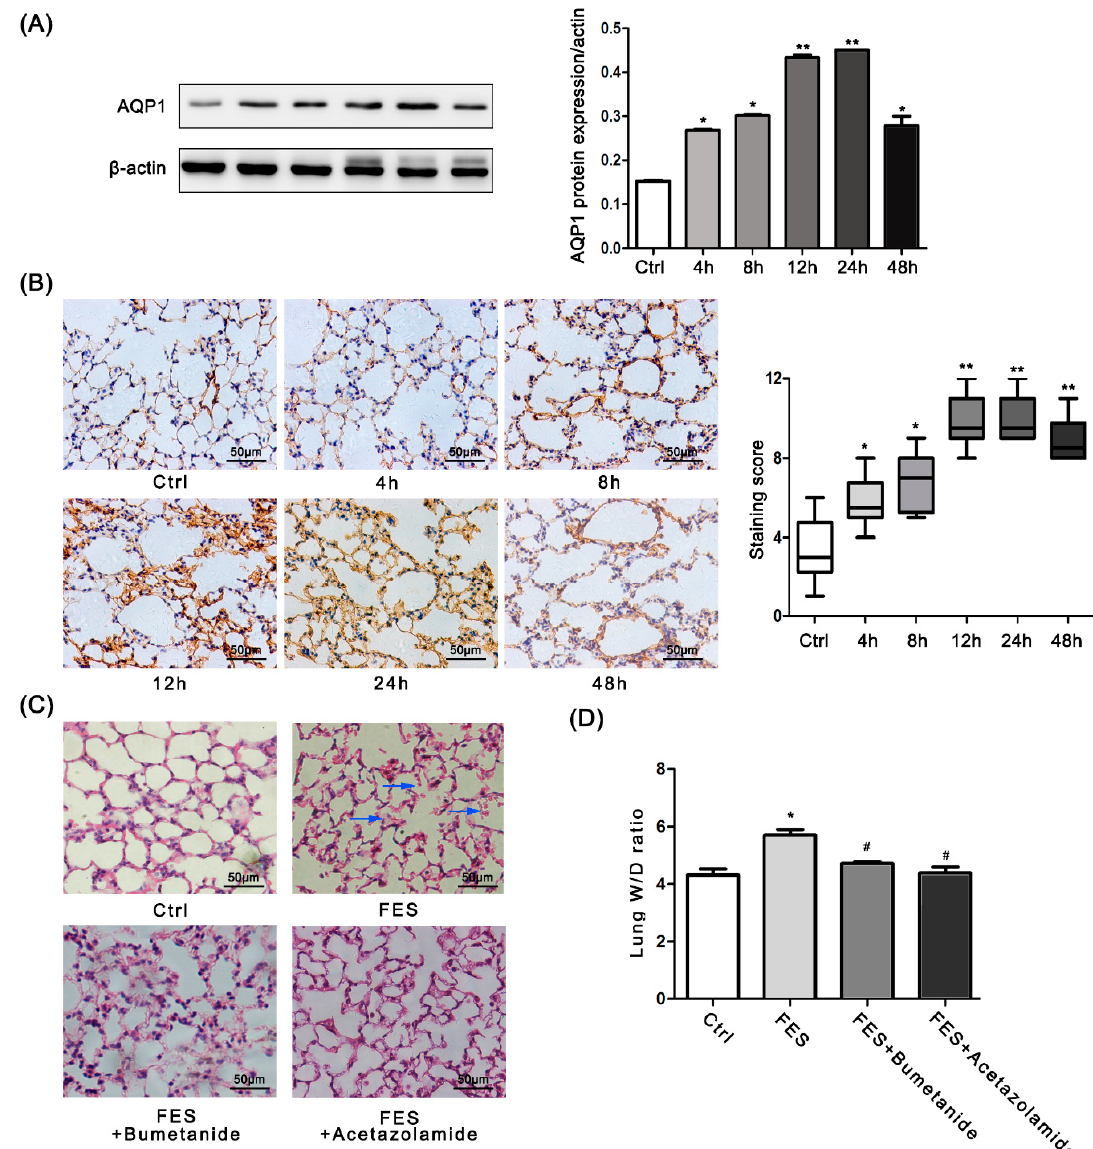
Figure 2. AQP1 is increased in lung of FES mice and inhibition of AQP1 reverses pulmonary edema in FES mice. ( A ) Western blot and ( B ) immunohistochemical analyses of AQP1 expression in the FES group at different time points after fat injection. Staining score was shown on the right; ( C ) Lung sections from the control, FES and FES + AQP1 inhibitors (bumetanideand acetazolamide, respectively) groups were stained with H&E. Blue arrow, ruptured alveolar wall, infiltration of red blood cells, and widened alveolar septa; ( D ) W / D ratio of the control, FES, FES + bumetanide and FES + acetazolamide groups. * p < 0.05; ** p < 0.001, the statistics were made by comparing with Ctrl group, respectively. # p < 0.05, the statistic was made by comparing with FES group.